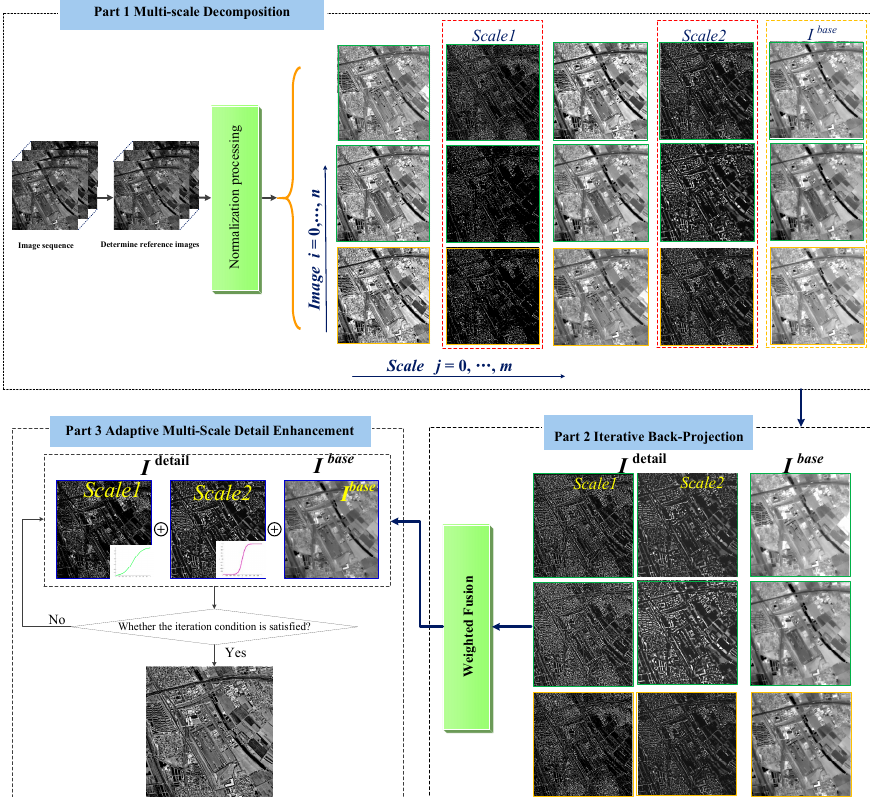
Figure 1. The framework of AMDE-SR.